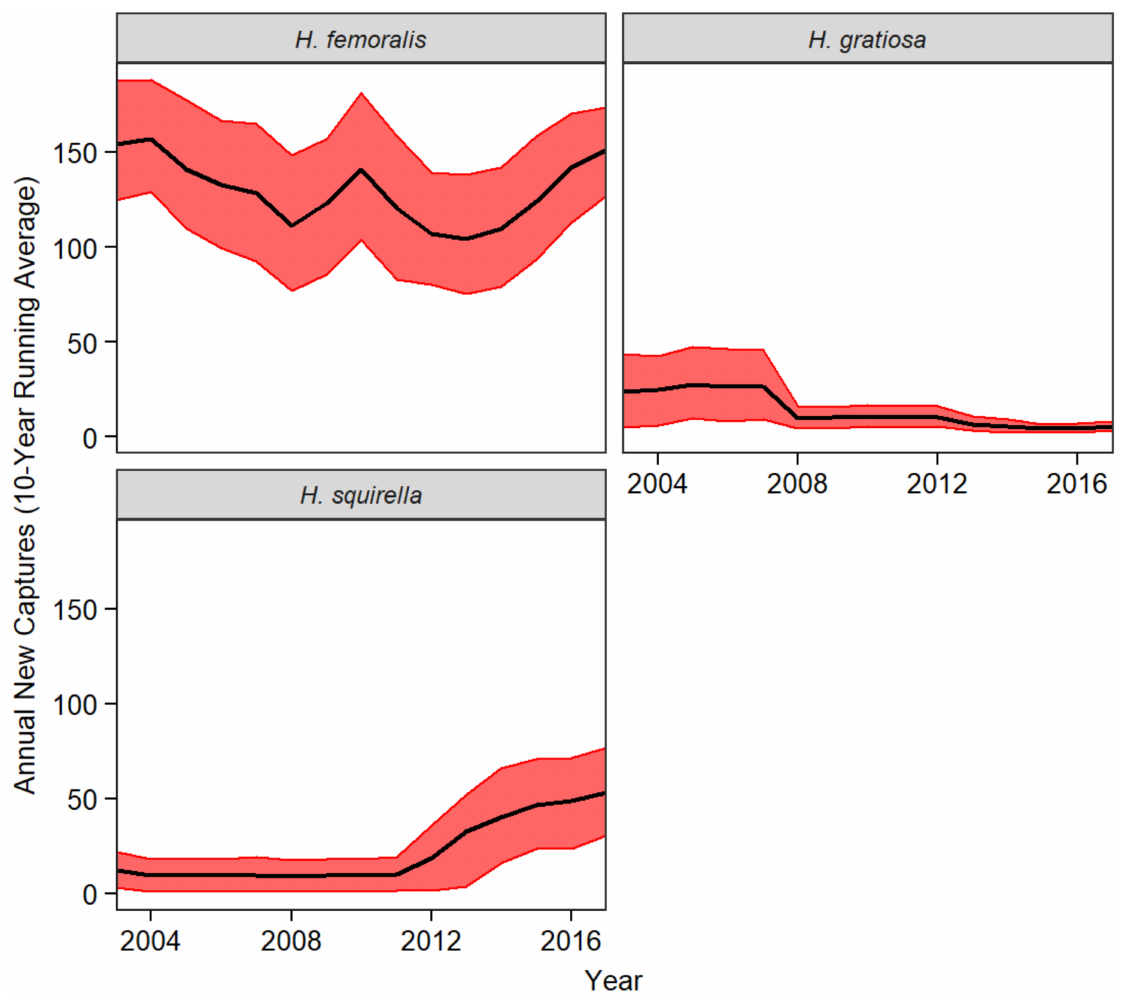
Figure 9. Ten-year running averages (2003–2017) of annual new captures (all age classes) for H. femoralis , H. gratiosa , and H. squirella . Confidence intervals represent 10th and 90th bootstrapped percentiles, simulated using 500